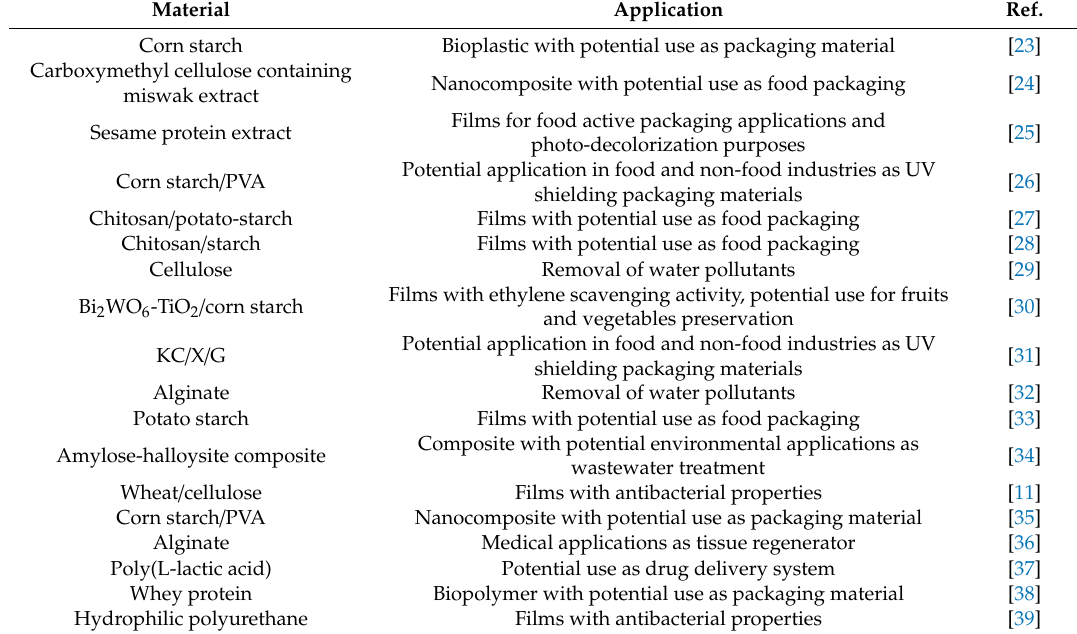
Wheat / cellulose Corn starch /